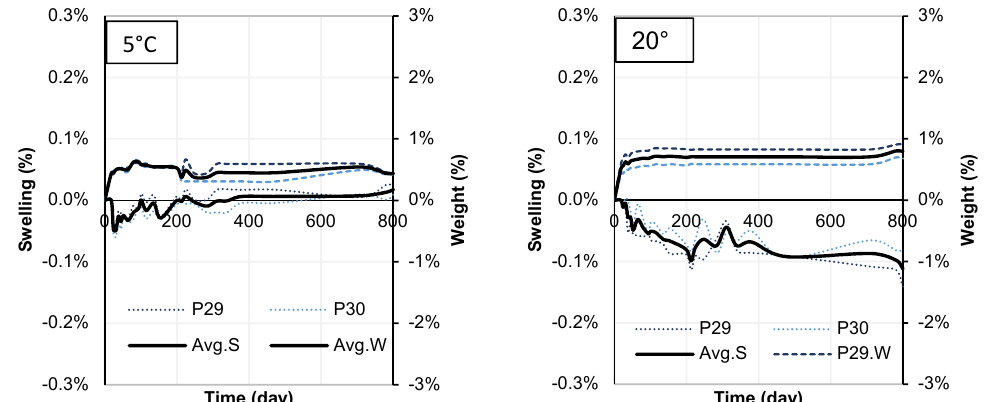
Figure A4. Swelling results in S + C + W3.